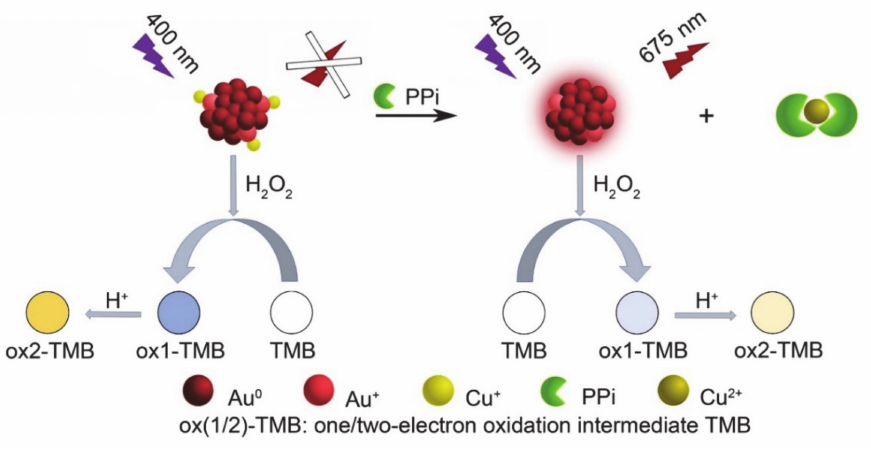
Figure 2. Schematic illustration showing the fluorescence and colorimetric methods of the PPi assay based on AuNCs-Cu 2+